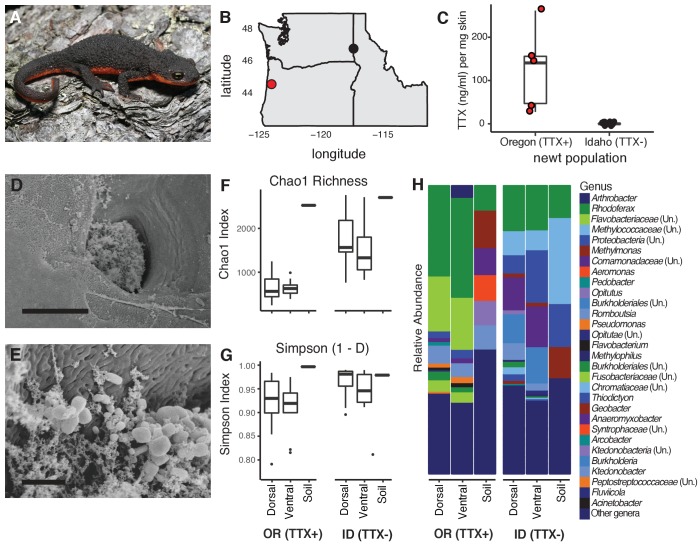
Characterization of the skin-associated microbiota of rough-skinned newts.(A) Rough-skinned newt (Taricha granulosa); photo by Gary Nafis (CC by ND NC 3.0). (B) Two populations of T. granulosa previously reported to possess either high concentrations of TTX (Lincoln Co, OR; red) or no TTX (Latah Co, ID; black) were compared in our study. (C) TTX measured from dorsal skin biopsies: newts from Oregon possessed 126.5 ± 42.1 ng mL−1 TTX (n = 5) while Idaho newts possessed no detectable TTX (n = 17). (D–E) Scanning electron micrographs of host-associated bacterial communities upon the dorsal skin surface and within the ducts of TTX-sequestering granular glands. Scale bars 10 µm and 1 µm for D and E, respectively. (F–G) Comparison of bacterial community richness and diversity between these two populations, along with soil samples collected contemporaneously from the ponds in which the newts were caught. Non-toxic Idaho newts possessed higher OTU richness (Chao1 index, t
unequal var. = 7.90, p<0.0001) and diversity (Simpson [1-D] index, t
unequal var. = 4.11, p<0.0001) than toxic Oregon newts. (H) Mean relative abundance of bacterial OTUs present in dorsal or ventral skin of each population, as well as local soil samples. Sample sizes for panels F-H were n = 12 for Oregon (TTX+) and n = 16 for Idaho (TTX-) newts.Figure 1—source data 1.Raw data for newt skin toxicity measurements by LC-MS/MS.Estimated TTX concentrations (ng mL−1) were calculated relative to a calibration curve of pure TTX standards.Figure 1—source data 2.The top 20 most abundant bacterial OTUs found among toxic (Oregon) and non-toxic (Idaho) newts.The relative abundance of each bacterial OTU within a sample was calculated and averaged across all samples for each population; these data are shown below as percentages. Taxonomy was assigned using the Ribosomal Database Project (Cole et al., 2014) and a confidence threshold of 80%. OTUs shared between the two populations are in bold.Figure 1—source data 3.Variation in alpha diversity between newt populations and sampling sites across the bodies of individual newts.Each value is shown as mean ± SEM.